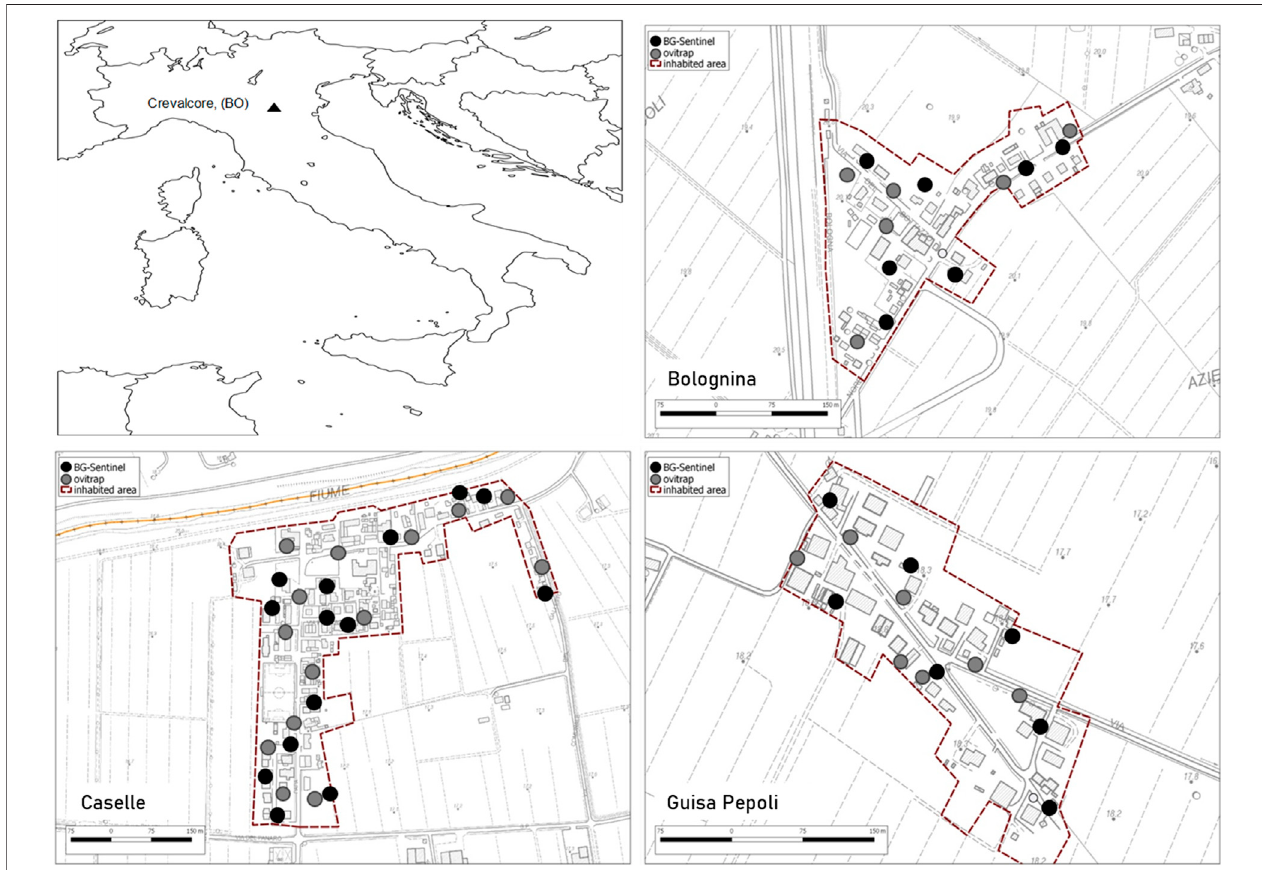
FIGURE1 | Studyareasin Crevalcore, Bologna, Emilia-Romagna, Italy, with indicationof thegeoreferenced monitoringstations (BG-sentinel and ovitraps) in each study localities.